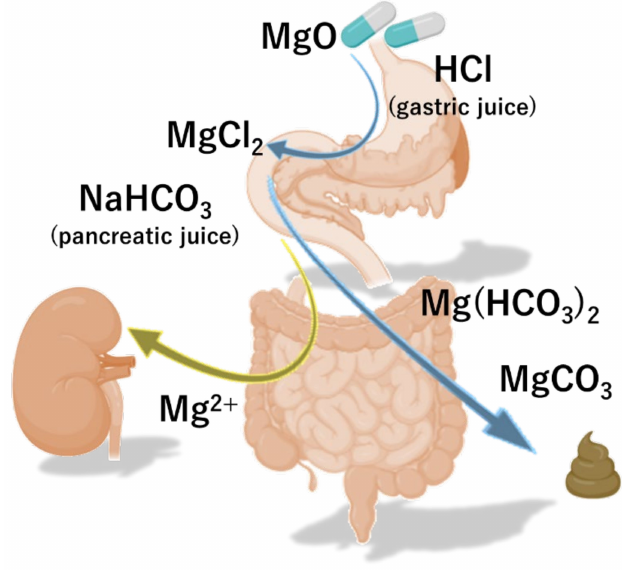
Figure 1. The pharmacokinetics of magnesium oxide. Magnesium oxide (MgO) is converted to sodium hydrogen carbonate (NaHCO 3 ) and magnesium carbonate (MgCO 3 ) by gastric and pancreatic juice, and exerts its effect as a salt